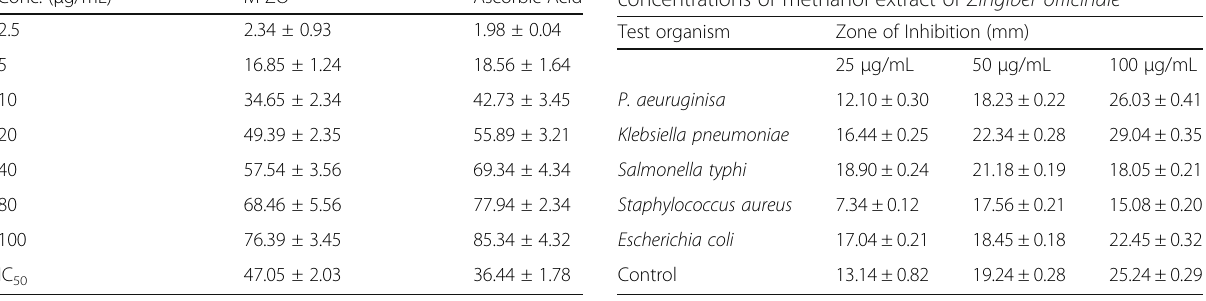
Values are mean±SEM of 3 determinations